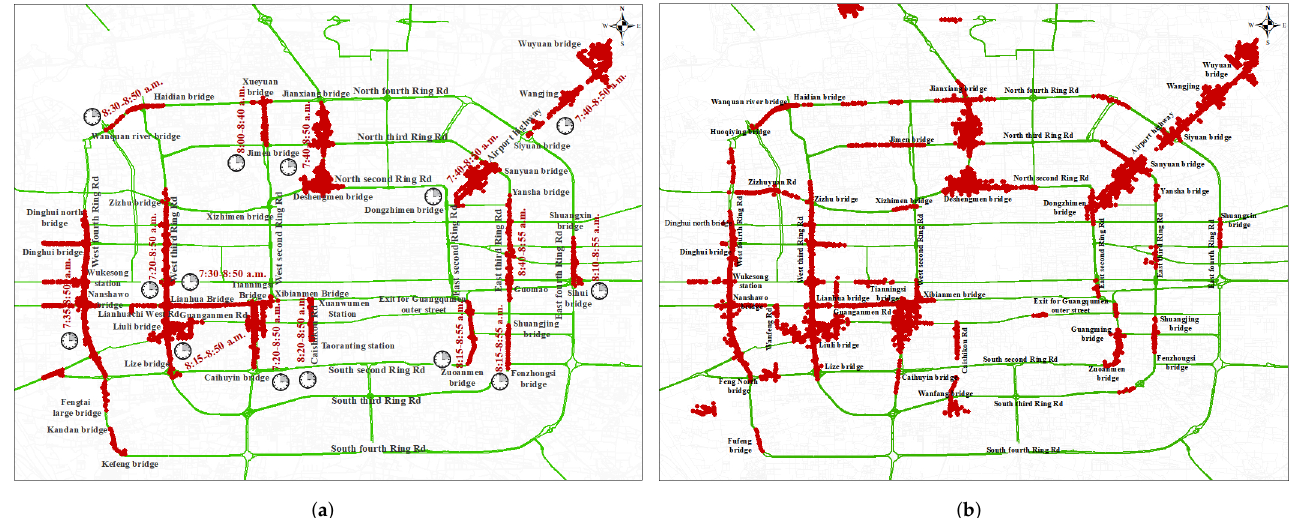
Figure 5. The discovered congested pattern during morning peak traffic hours on working days. ( a ) The LMCPs generated by our algorithm; ( b ) The swarm pattern generated by CLUR algorithm.